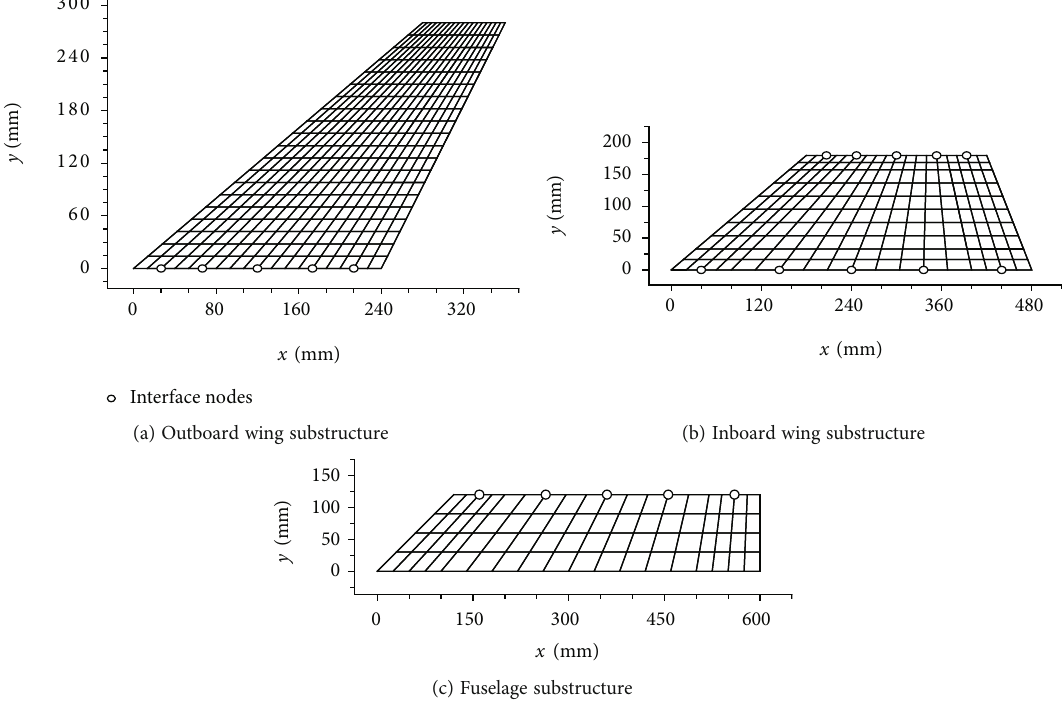
Figure 2: Finite element models of the three